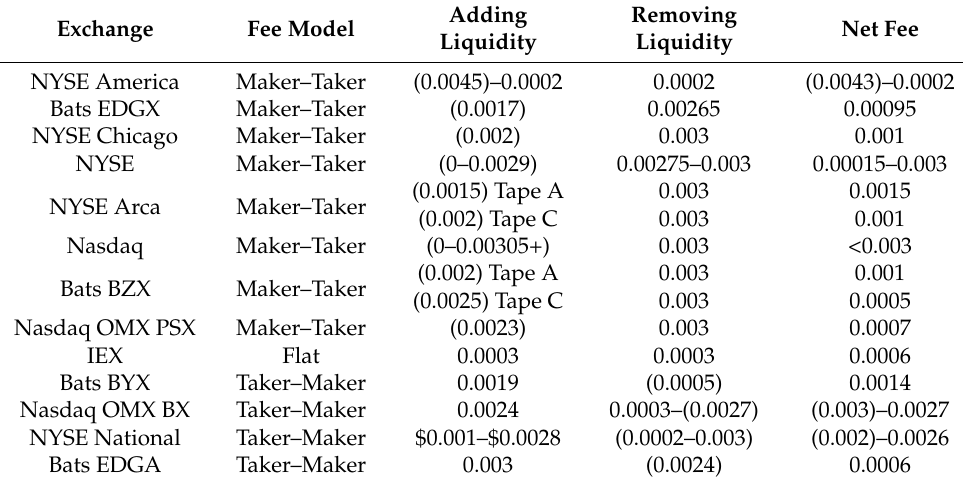
Table 2. U.S. national exchanges fee